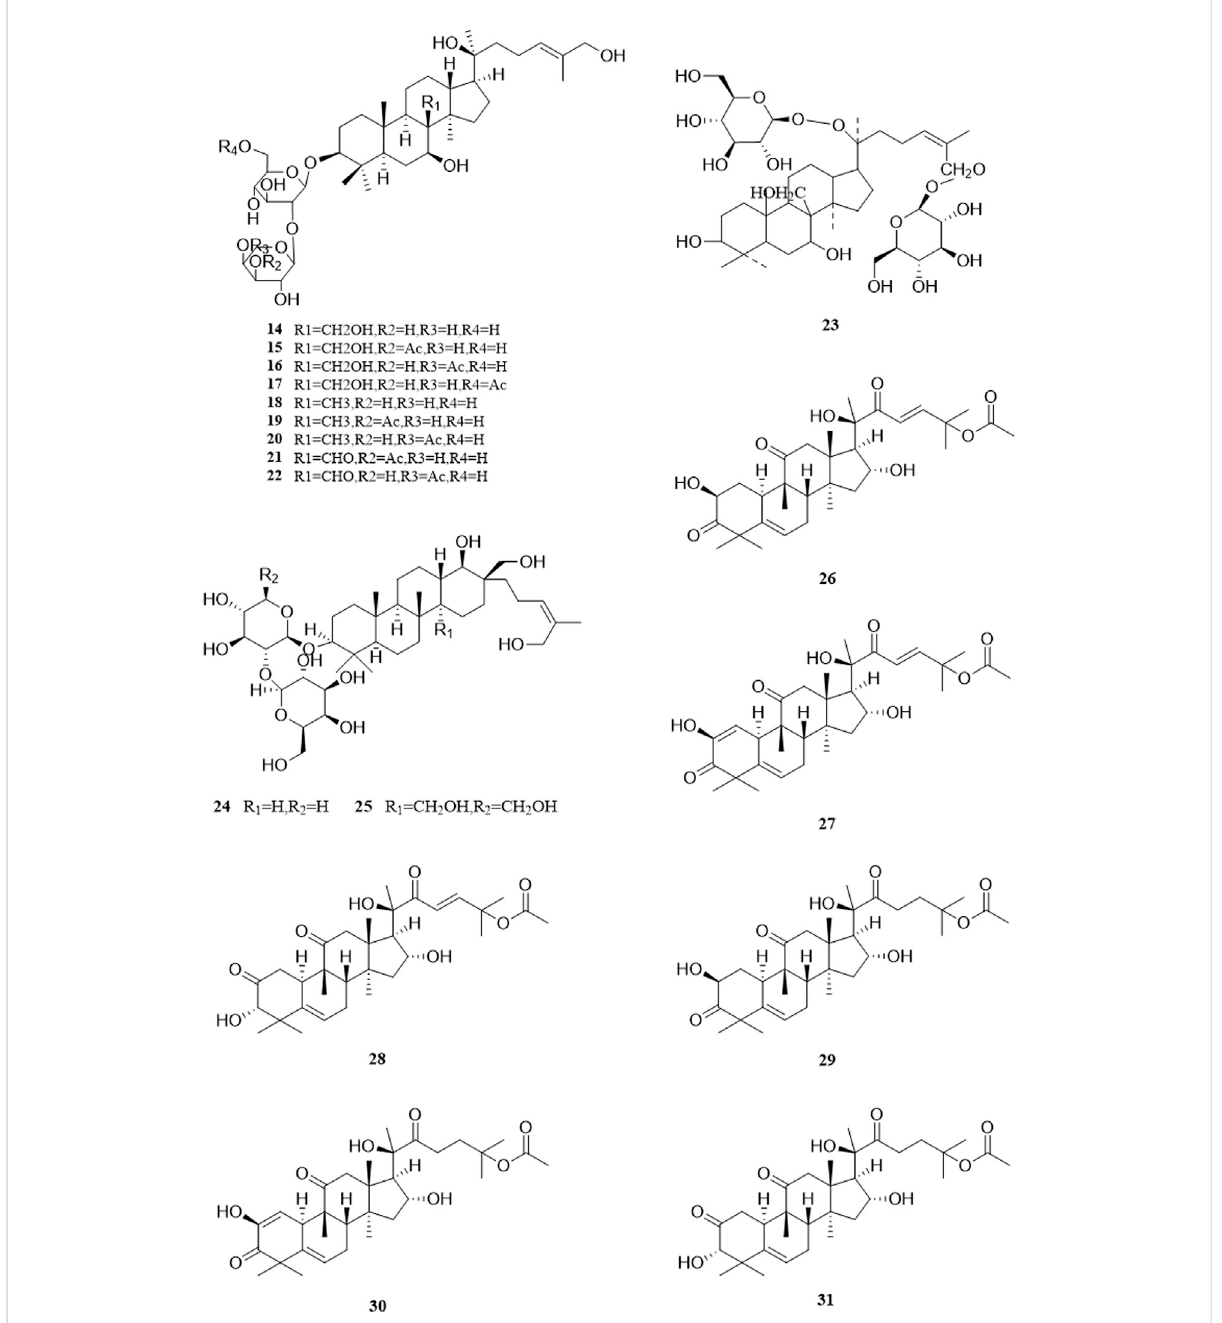
FIGURE 3 Structure of triterpenoids from Bolbostemma paniculatum (Maxim.) Franquet.